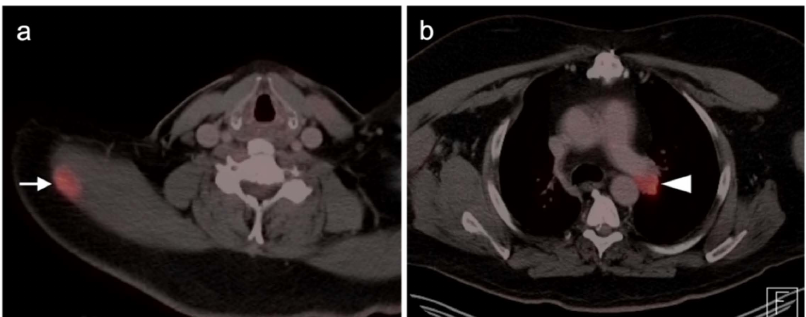
Figure 15. Undifferentiated pleomorphic sarcoma. ( a ) Axial FDG PET-CT image of the low neck shows an intramuscular hypermetabolic mass in the right trapezius muscle (white arrow). ( b ) Axial FDG PET-CT image of the chest shows a hypermetabolic (metastatic) left hilar node (white arrowhead).